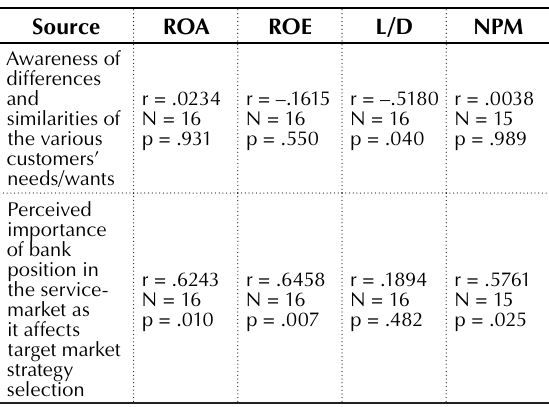
Table 5. Correlations between target